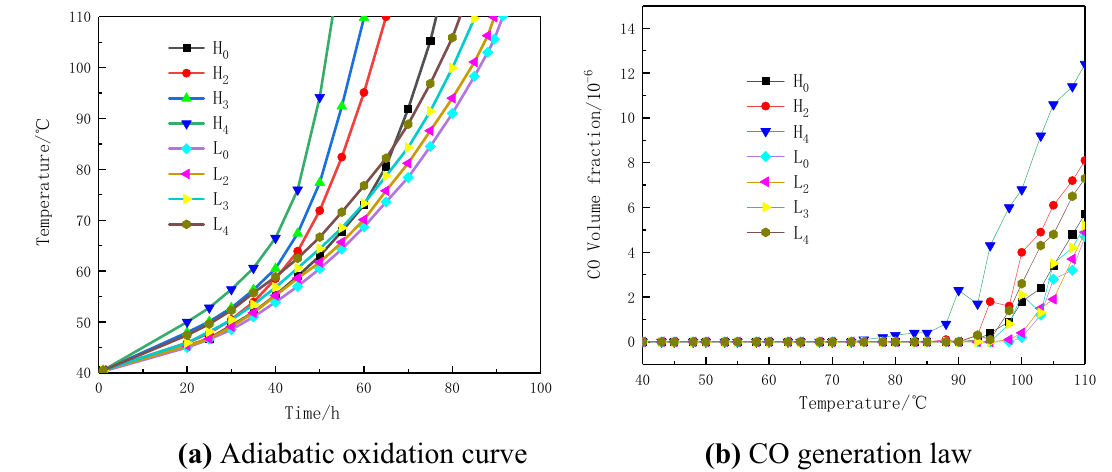
(a) Adiabatic oxidation curve (b) CO generation law Figure 3. Adiabatic oxidation curve and CO generation curve of coal